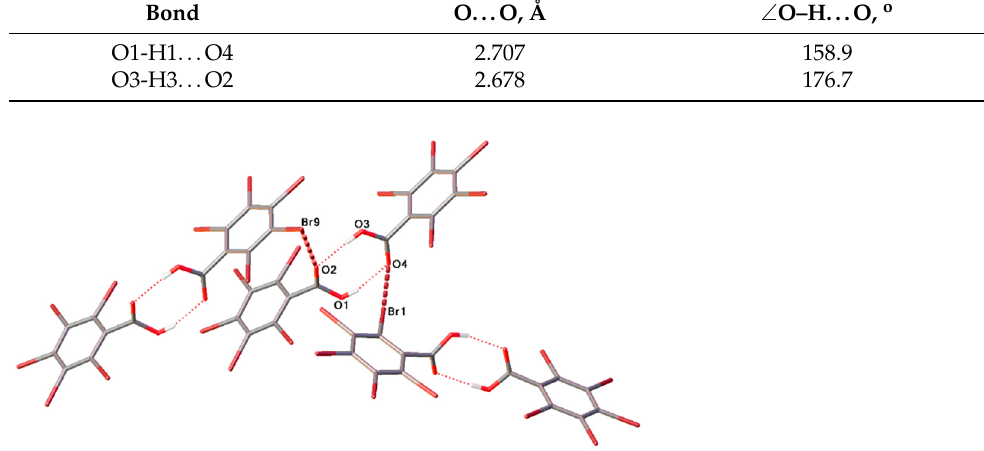
Figure 3. Crystal packing of 1 . Hydrogen O-H…O bonds are illustrated with dotted lines and Br…O contacts are illustrated with dashed lines.